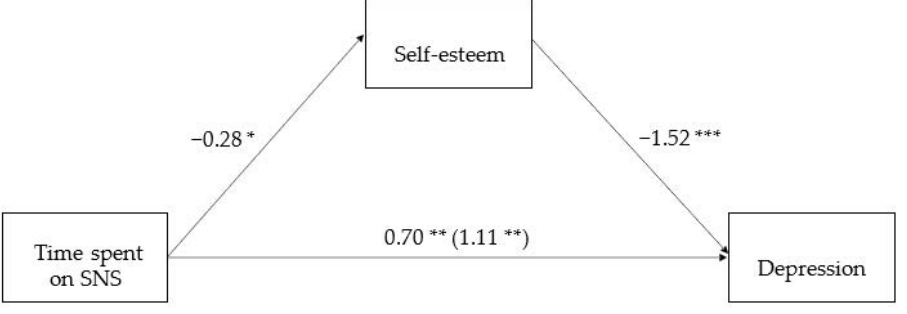
Figure 1. Self-esteem as mediator in the relation between Time spent on SNS and Depression. Note: p < 0.001 ***, p < 0.01 **, p < 0.05